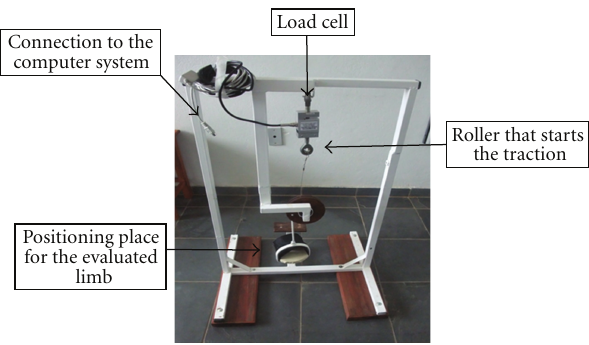
Figure 1: Measuring instrument, coupled to the load cell, used to measure the irradiation and the force generated by the PNF